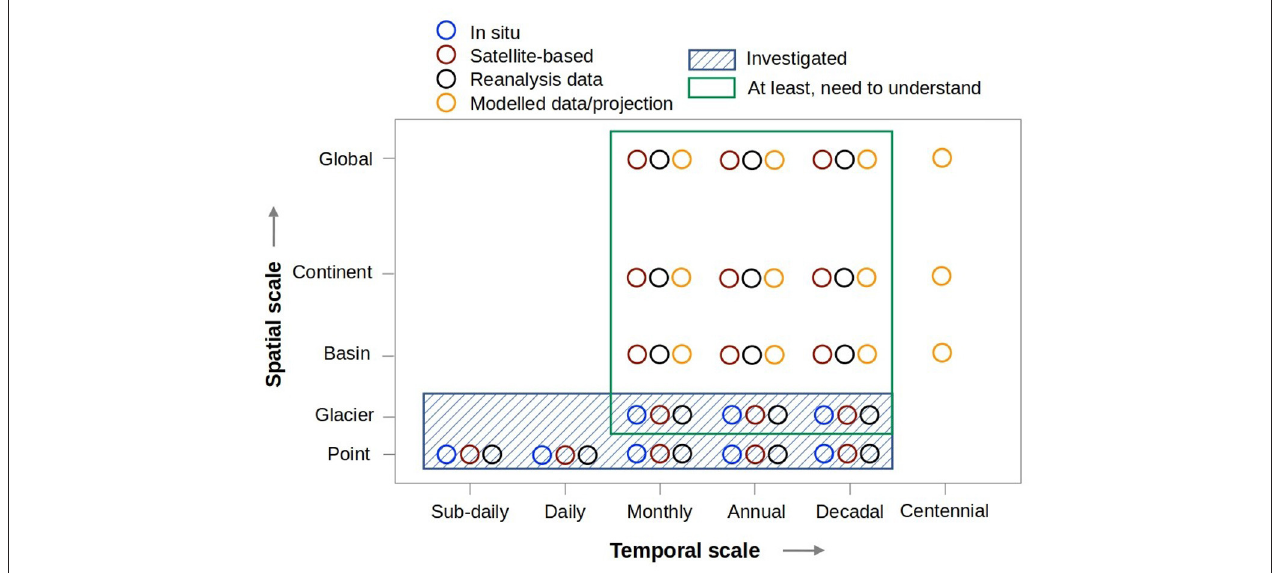
FIGURE 4 | Spatiotemporal timeline of research investigation and understanding of the cryosphere and regional water resources in the Himalayan region. Relative data availability from various techniques/methods are also